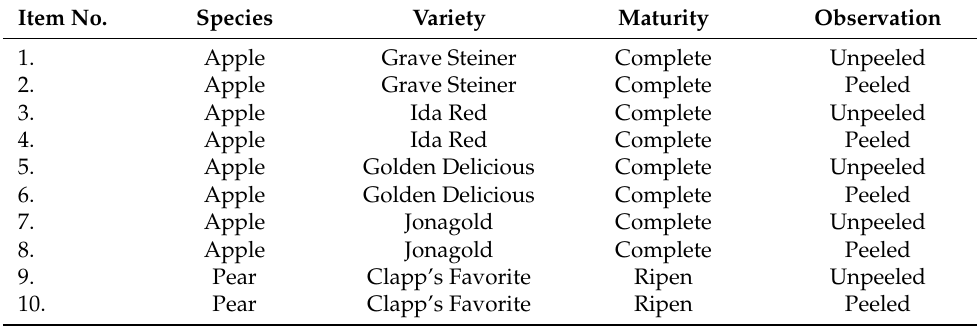
Table 1. Texture analysis was conducted to analyze various fruit species and varieties [22].